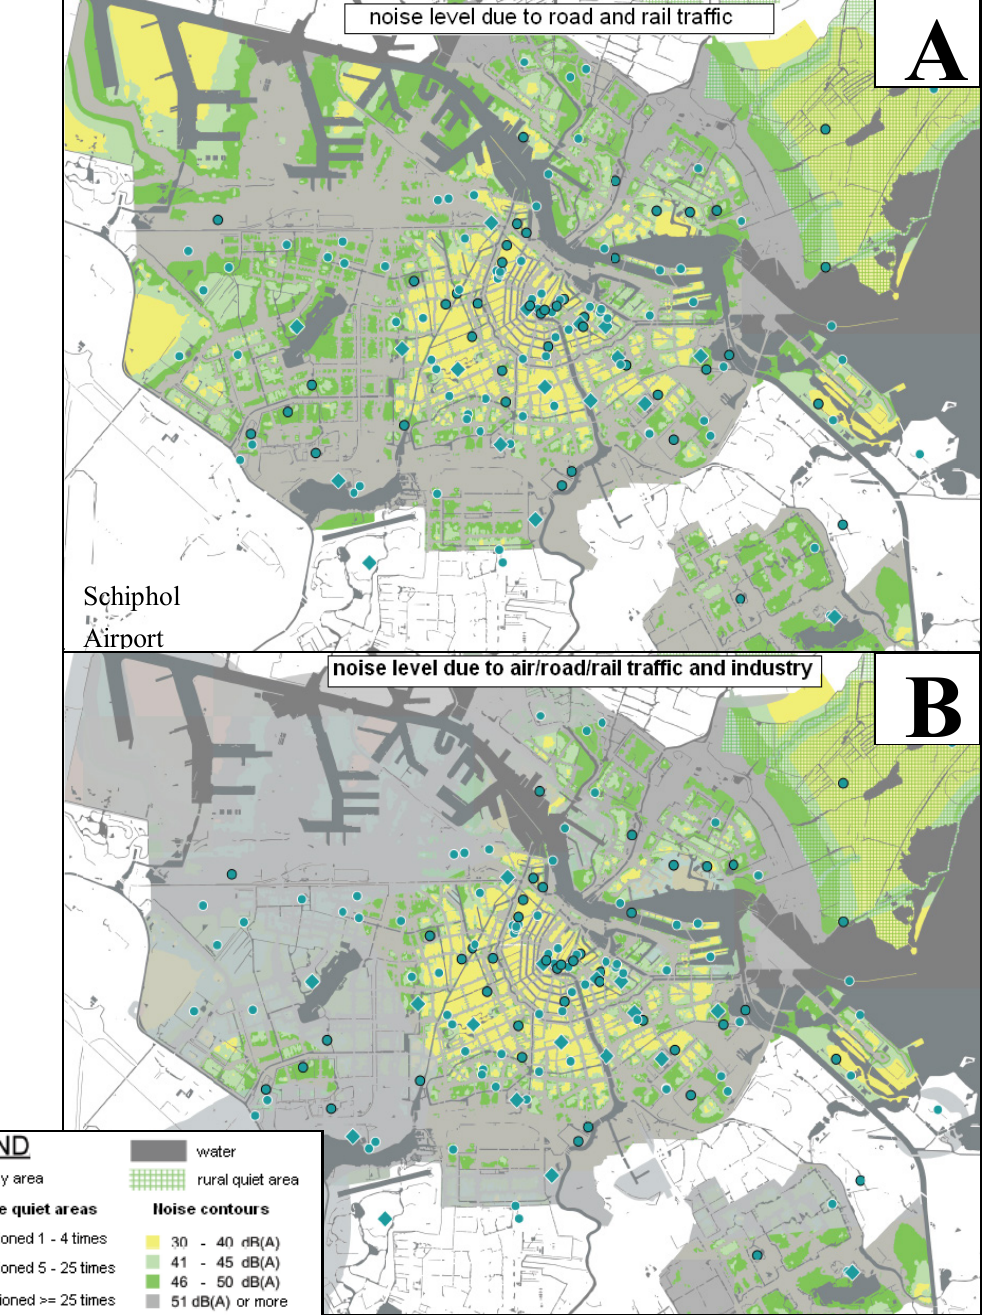
Figure 11. Quiet areas on low-noise map; ( A ) daytime sound level (L ) of road- and rail day traffic within the Amsterdam city limits in 5 dB intervals from 30 to 50 dB(A); ( B ) highest value of L road- and rail traffic, L of air traffic and L of industry. day den den